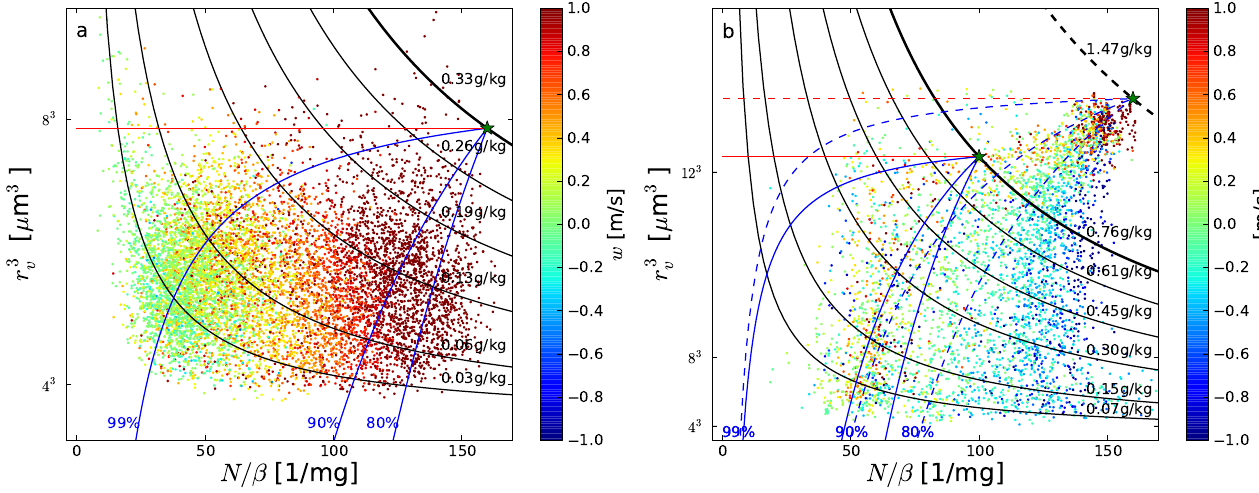
Fig. 16. The N − r 3 v diagrams: (a) at the height of 500m (i.e., within the cumulus layer); (b) at the height of 1200m (i.e., at the stratocu- mulus top). Black lines show isolines of LWC; the thicker lines represent estimations of the adiabatic LWC. Red lines indicate extremely inhomogeneous mixing and blue lines indicate homogeneous mixing for different relative humidities of entrained air. The starting points for the mixing lines are marked as the green stars. For the stratocumulus, two starting points are selected to represent the cumuli that penetrate into the stratocumulus layer. Color marks the vertical velocity and the color scale is shown to the right of each panel.